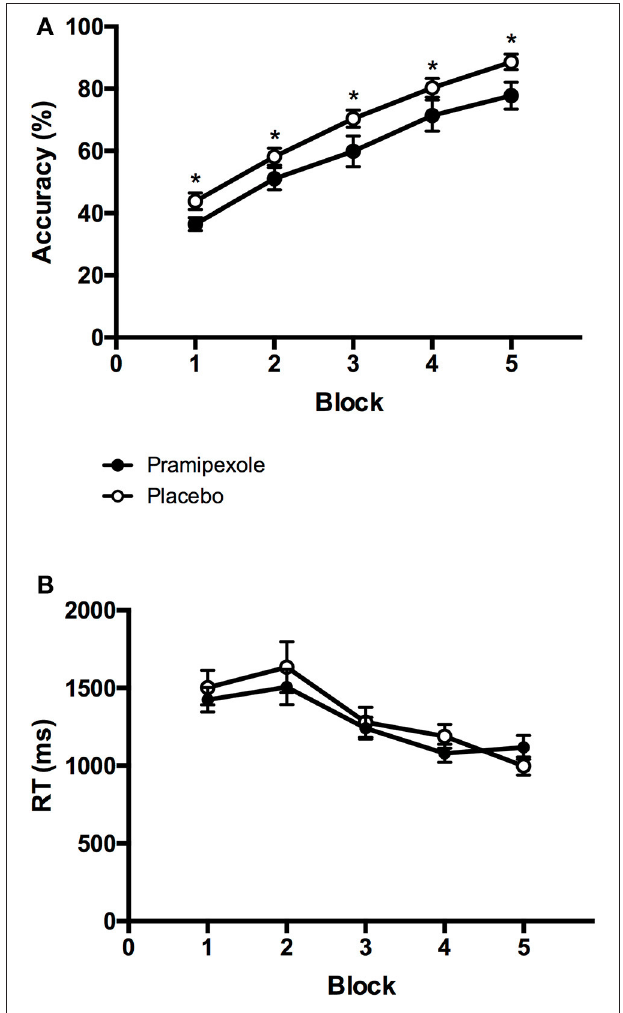
FIGURE 3 | Mean (A) percent accuracy scores and (B) key-press response times from each block for the pramipexole and placebo groups. Error bars represent standard error of the mean. Significant differences between the two groups are marked with asterisks ( p <